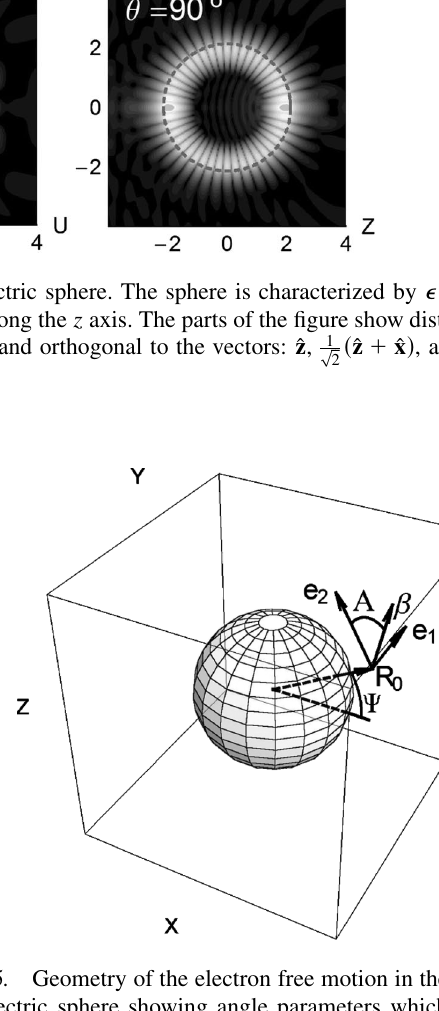
FIG. 5. Geometry of the electron free motion in the vicinity of a dielectric sphere showing angle parameters which define the closest approach point and the velocity